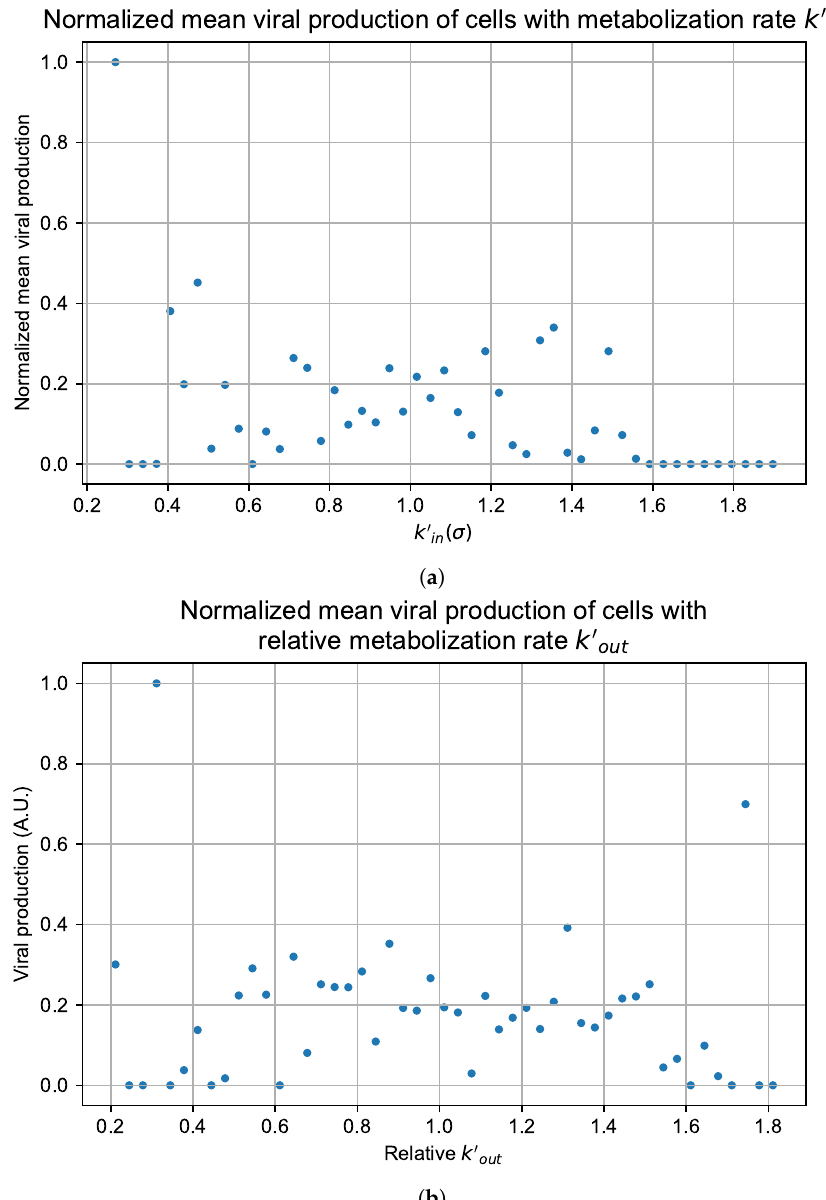
Figure A125. Mean viral production of cells versus their metabolism rates normalized by the maxi- mum mean production with rapid clearance parameters. ( a ) Results for simulations varying only k in . ( b ) Results for simulations varying only k out